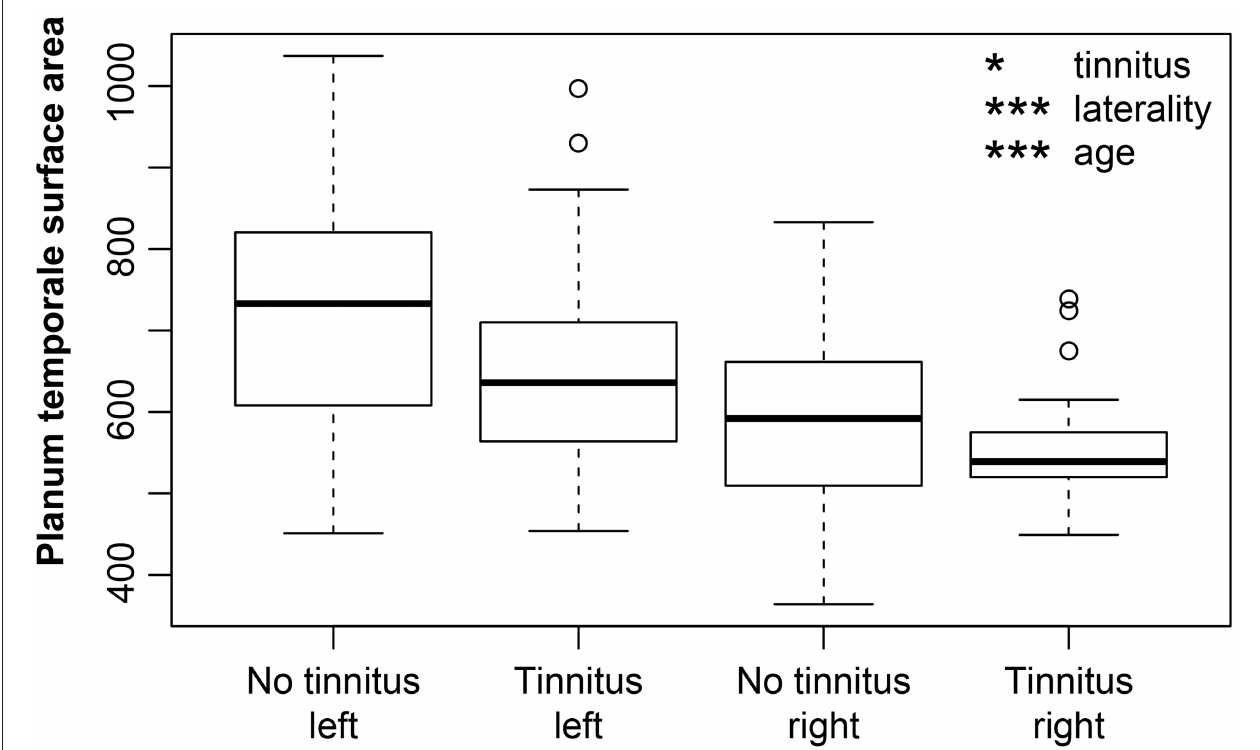
FIGURE 6 | The cortical surface area is decreased due to the tinnitus in the PT (apparent when groups with mild and expressed presbycusis are compared). Left PT surface area is larger. PT surface area decreases with increasing age. Data are compared based on M3 (only elderly groups). Tinnitus—include elderly groups with